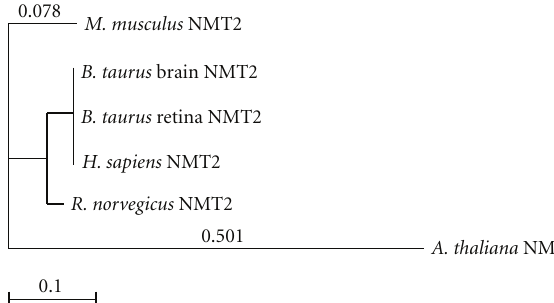
Figure 2: Molecular phylogenetic tree of the amino acid sequences of NMT2s from various species. The tree was constructed by the neighbor joining method, based on sequence